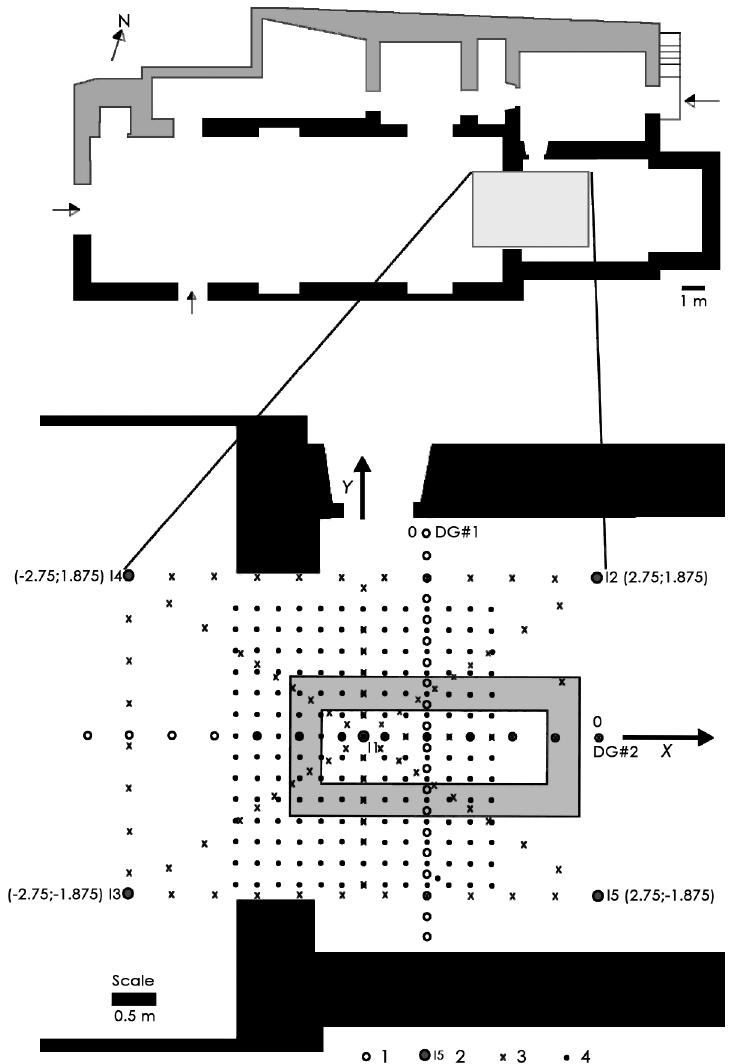
Fig. 1. Inside map of Varzea Church and location of resistivity surveys. 1 – dipole-dipole data; 2 – pole-pole injection; 3 – pole-pole readings; 4 – gradient